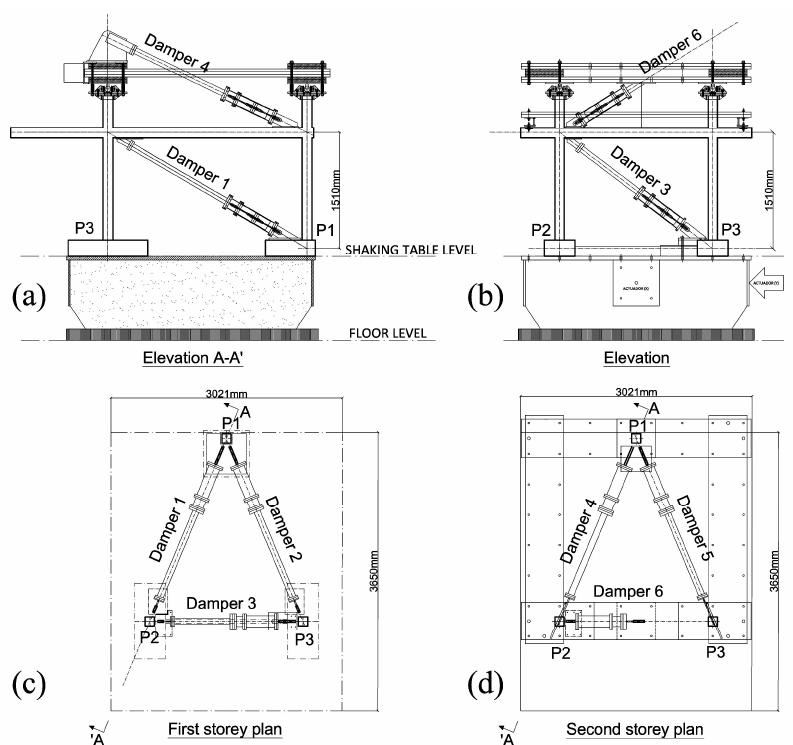
Figure 19. Details of the experimental set up for the shake table tests: ( a ) elevation view A-A’, ( b ) elevation, ( c ) plan (first storey), ( d ) plan (second storey).